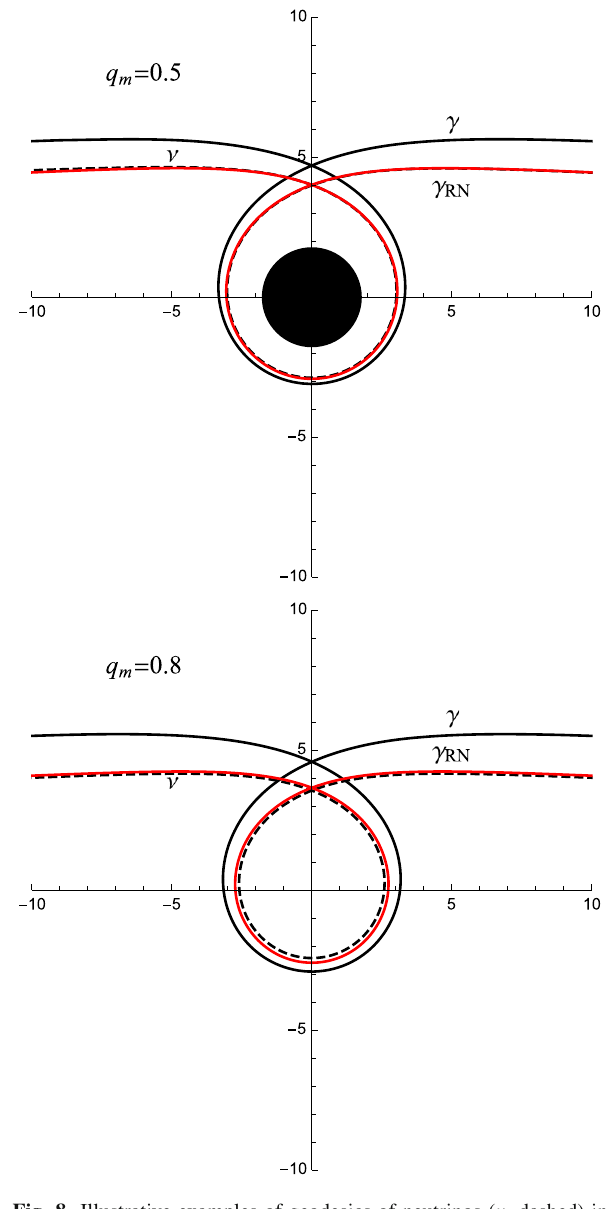
Fig. 8 Illustrative examples of geodesics of neutrinos ( ν , dashed) in Bardeen and photons ( γ , solid-black) in effective-Bardeen, and pho- tons in RN ( γ RN , solid-red) geometries for two representative values of magnetic charge parameter q = 0 . 5, 0 . 8. The corresponding impact parameters are presented in Table 3